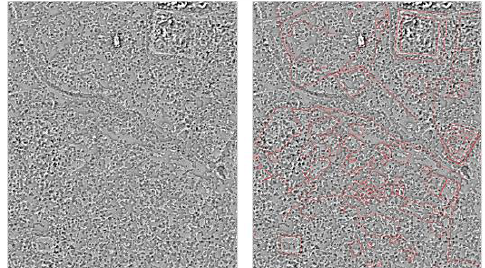
Figure 17 – A difference Digital Elevation Model (GSD 1m) derived from the Pleiades DEM of the Makhmúr al-Qadíma site with overlaid objects of interest on the right picture.